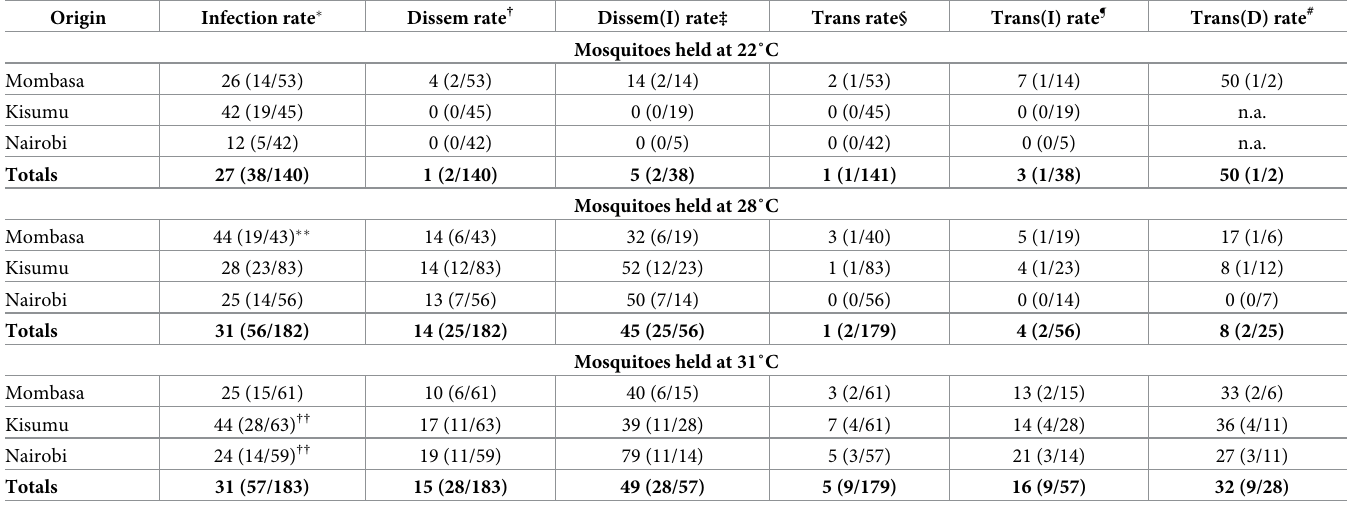
Table 2. Vector competence of Aedes aegypti originating from three Kenyan cities, exposed to dengue-2 virus and incubated at selected temperatures.